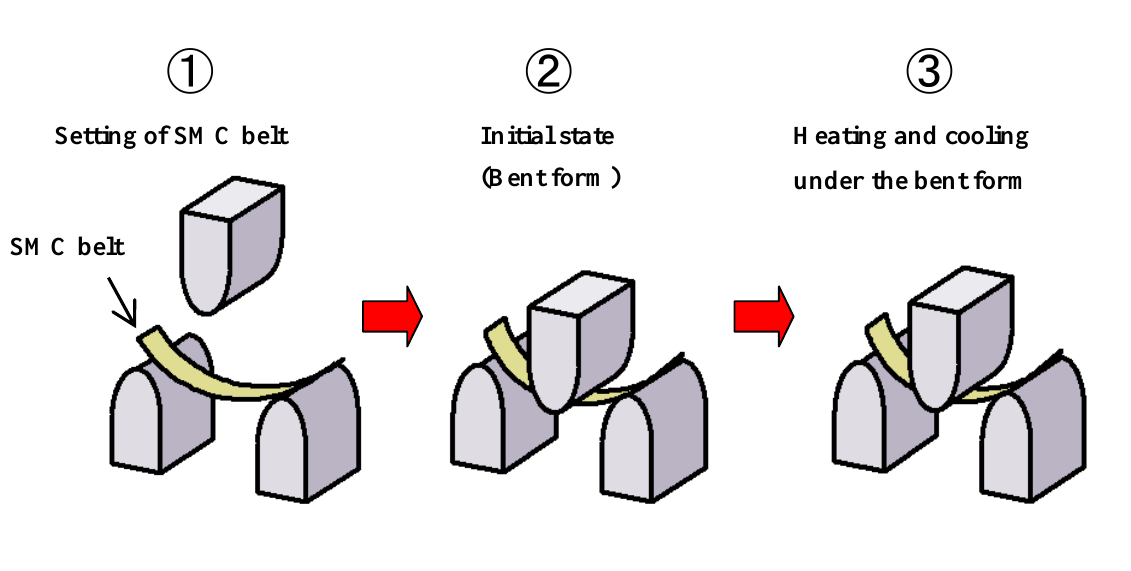
Figure 7. Experimental procedure of recovery force by the three-point bending test with heating and